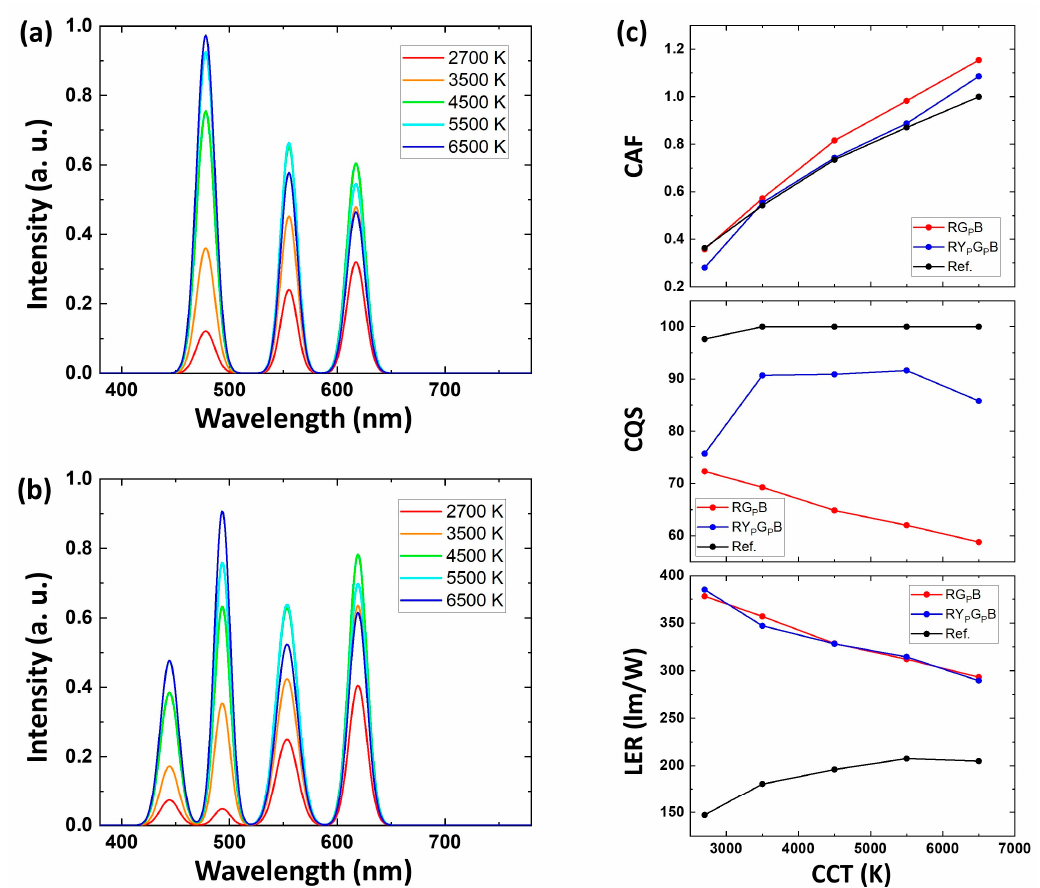
Figure 8. SPDs of individual optimal solution at different CCTs for ( a ) RG P B (peak wavelengths: 477.9 nm, 555.1 nm and 617.3 nm) and ( b ) RY P G P B (peak wavelengths: 444.2 nm, 493.3 nm, 553.3 nm, and 619.1 nm) type SSL. ( c ) The detailed performance as a function of CCT.